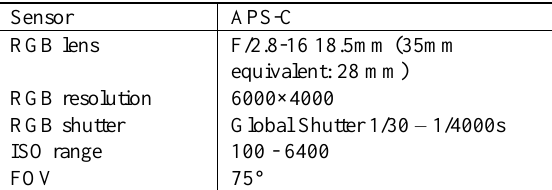
Table 2. Sensefly Aeria X camera specifications